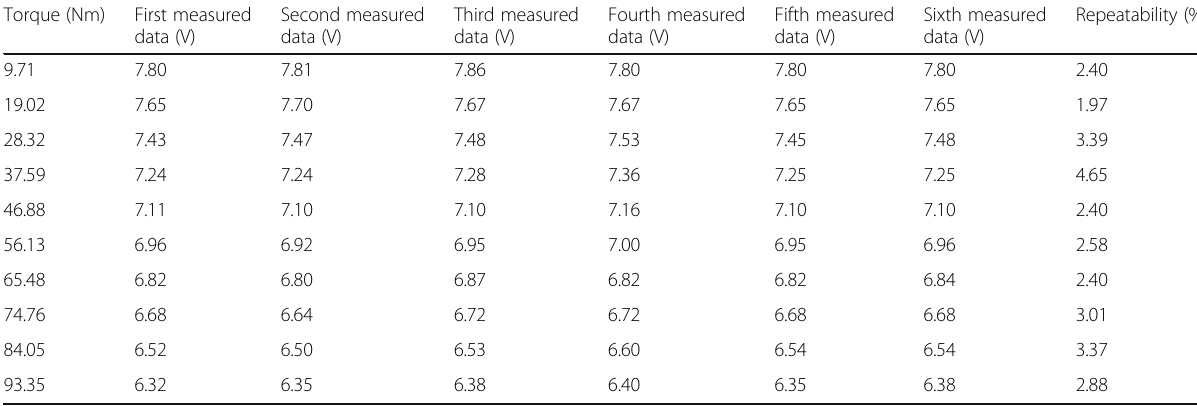
Table 1 Repeatability experiment data Torque